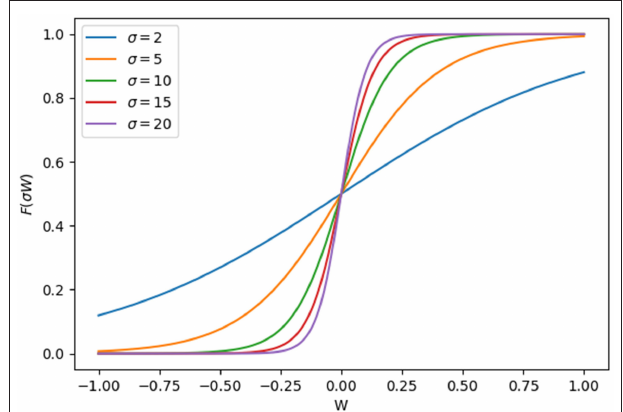
FIGURE 9 | Shape of the force function F ( σ W ) vs. different values of W . W , the combination of effects of all input regulation on a certain